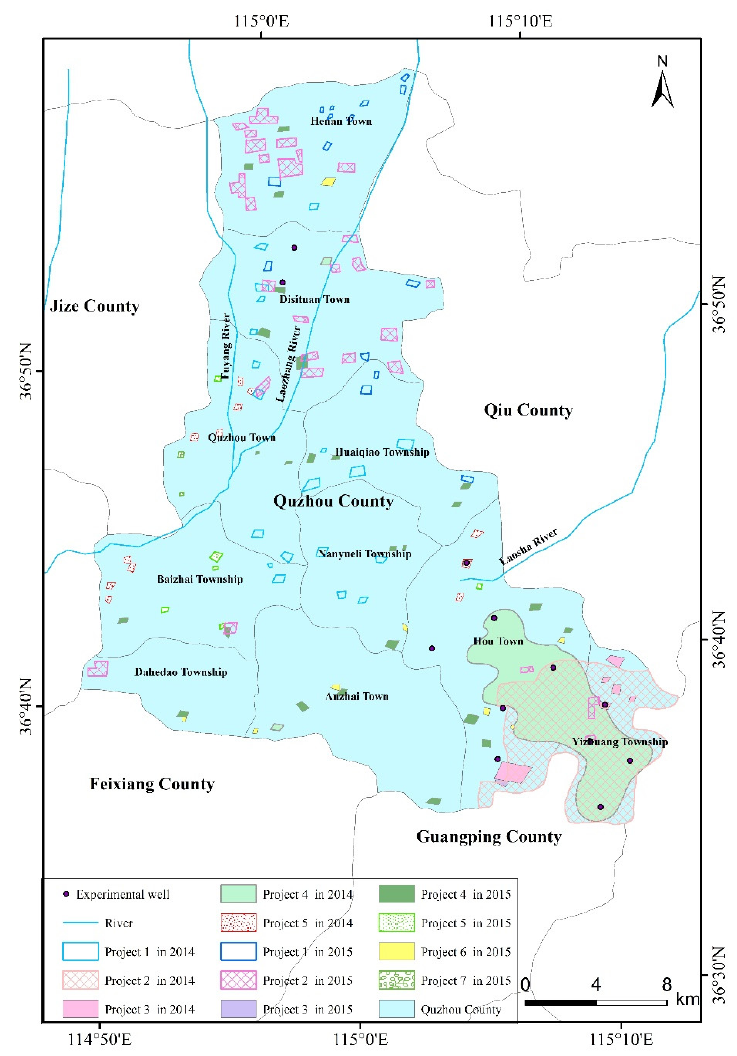
Figure 1. Distribution map of groundwater exploitation restriction projects in Quzhou.